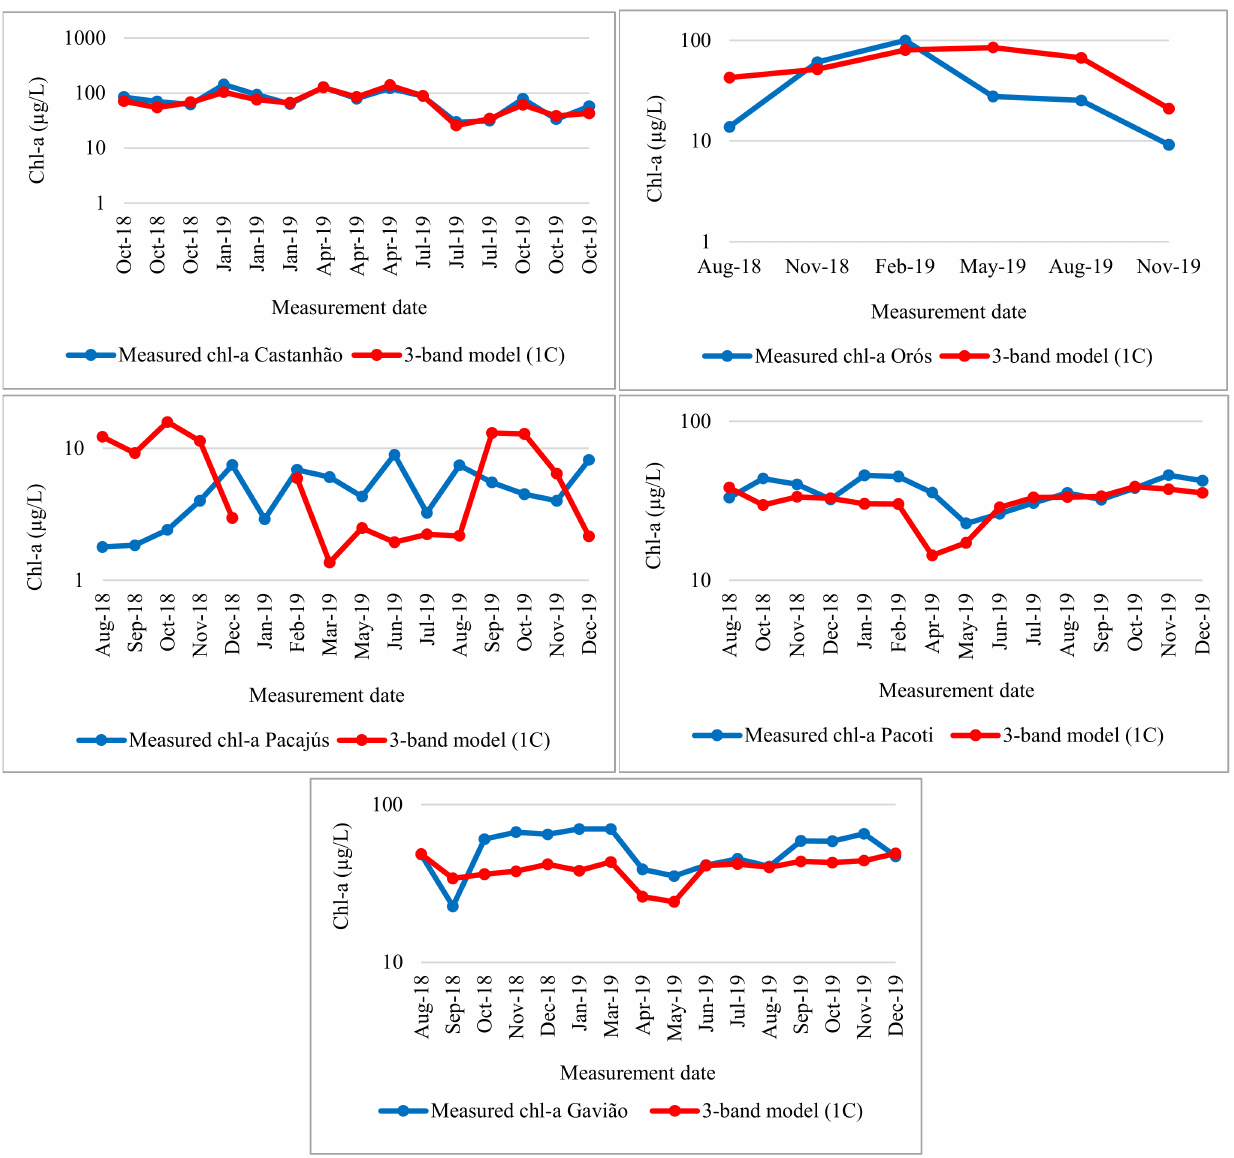
Figure 3. Comparison between the chl-a estimated by the three-band algorithm (Equation (2)) and the chl-a measured for the Castanh ã o, Or ó s, Pacaj ú s, Pacoti and Gavi ã o reservoirs, referring to the validation data covering the period from August 2018 to December